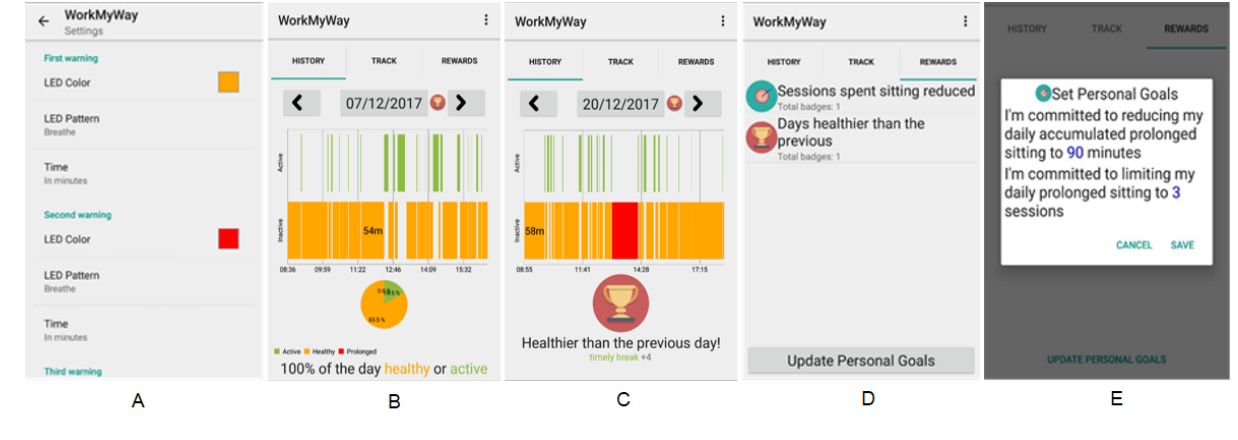
Figure 6. Screenshots of the WorkMyWay app.